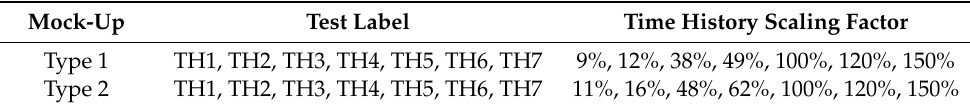
Table 2. Scaling factors for earthquake records for both mock-ups.